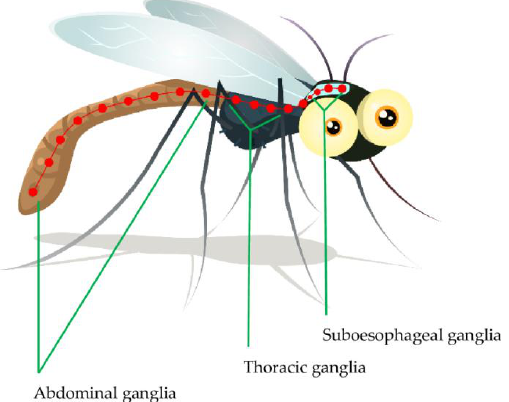
Figure 1 . The nervous system ganglia of Anopheles